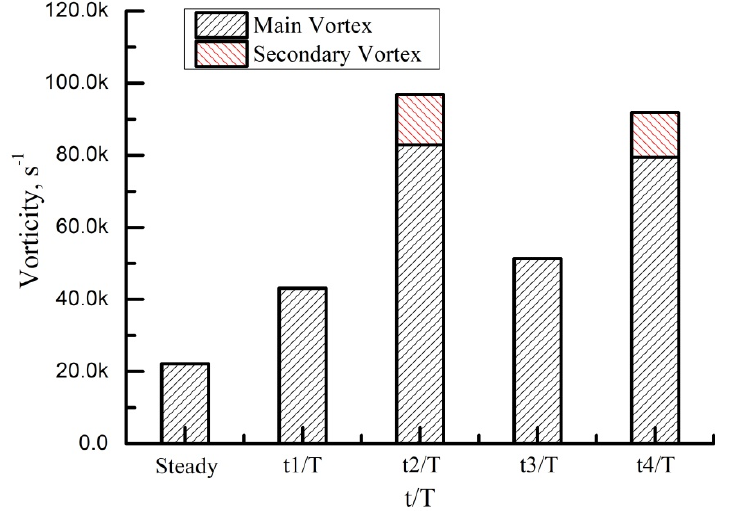
Figure 21. Vorticity of the vortex cores shown in Figure 19. For both the cases with two vortex the upstream one has the larger vorticity and is thus named as ‘main vortex’.